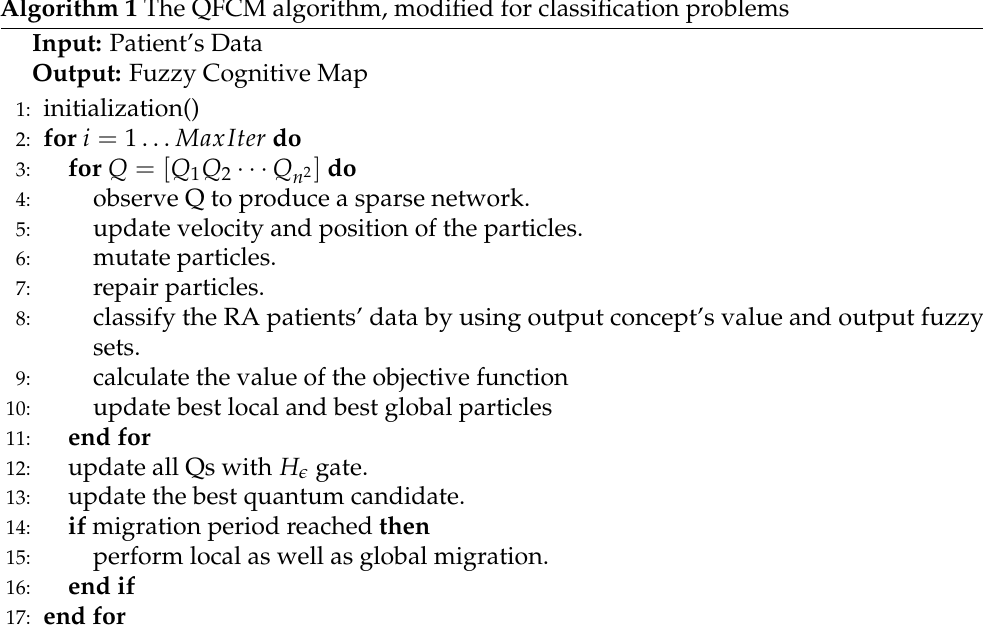
Algorithm 1 The QFCM algorithm, modified for classification